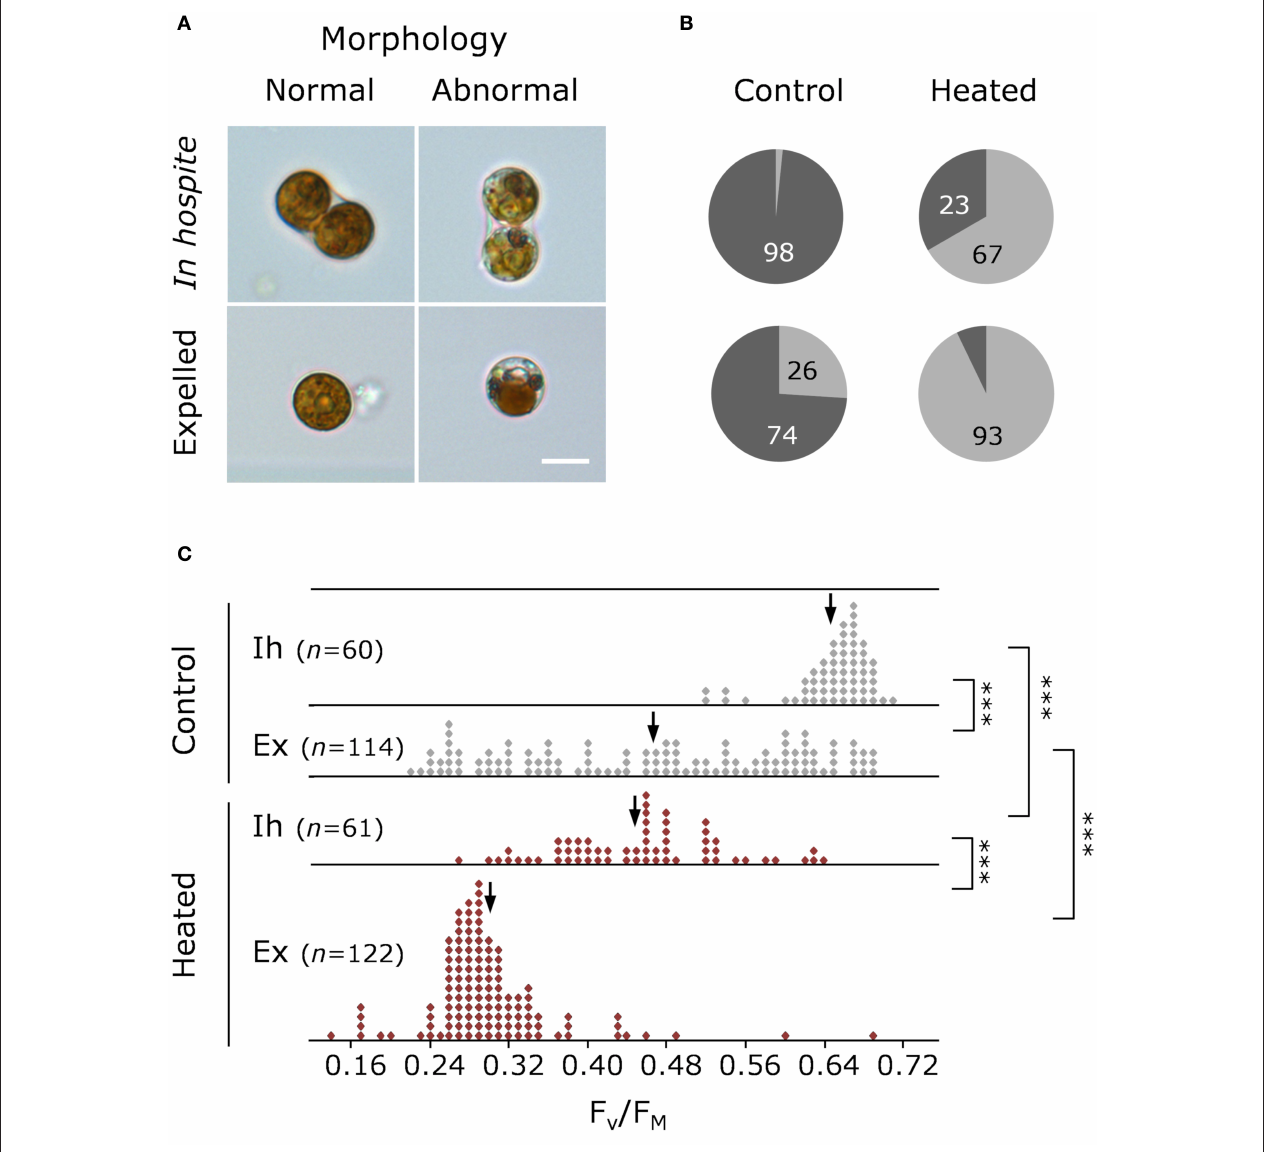
FIGURE 3 | Health and morphology of Symbiodinium on day 11. (A) Representative light microscopy images of normal and abnormal morphologies, and (B) percentage of normal (dark gray) and abnormal (light gray) in hospite and expelled cells from control and heated corals. (C) Single-cell maximum quantum yield of PSII (F V /F M ) of in hospite and expelled cell populations from three individual coral fragments from control (gray) and heated (red) corals. Scale bar = 10 µ m. Down arrows denote population median. Vertical brackets indicate significant differences in population distributions (Kolmogorov Smirnoff test) and medians, and asterisks denote significance level *** P <